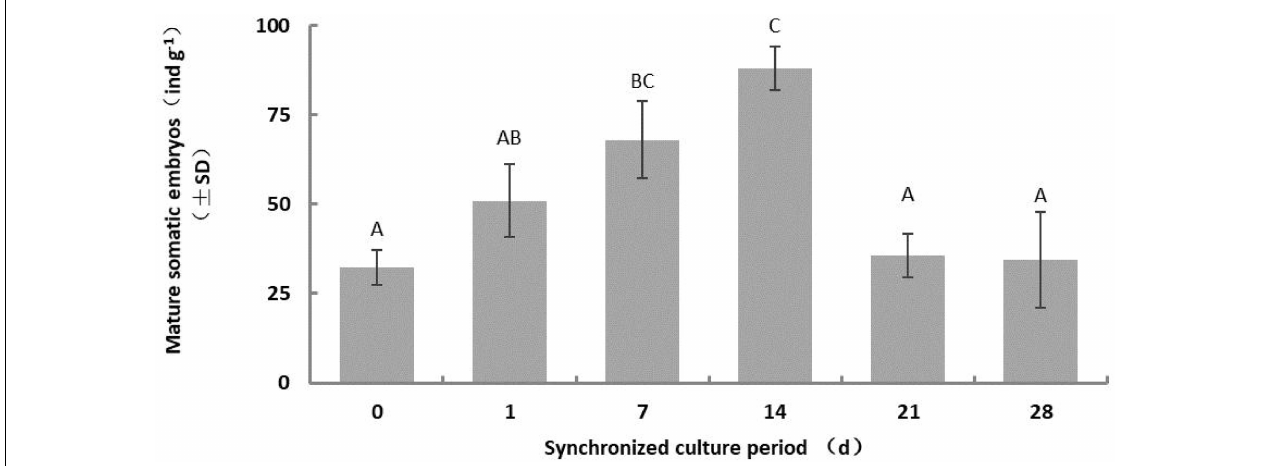
FIGURE 2 | Effect of the synchronous culture period on somatic embryo maturation of L. olgensis . SM contained 1/2 BM salts, 60 g · L − 1 sucrose, 10 g · L − 1 inositol, 1 g · L − 1 glutamine, and 0.5 g · L − 1 hydrolyzed casein. Each value represents the mean of three independent experiments with standard deviation (SD). Different letters indicate p < 0.05 (Duncan’s multiple range